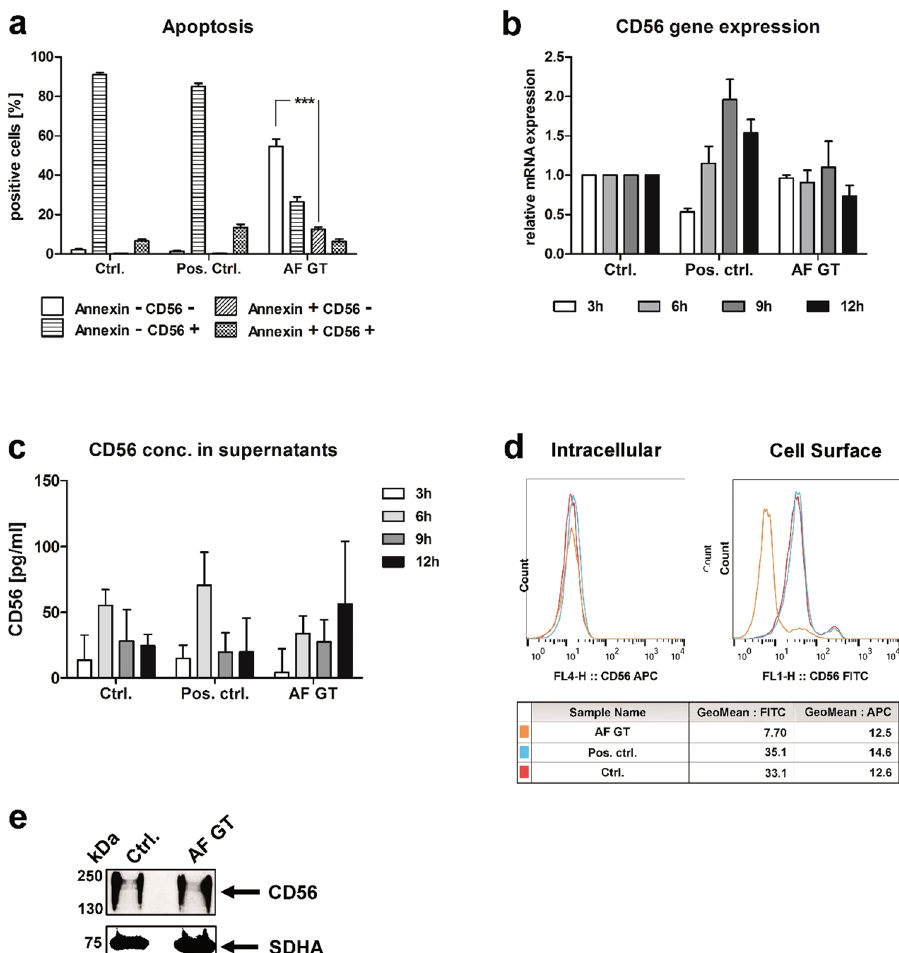
Figure 2. CD56 reduction is not induced by apoptosis, deregulation of protein and gene expression. NK cells were either treated with 500 U/ml IL-15 and IL-2 (Pos. ctrl.), with A . fumigatus germ tubes (AF GT, MOI 0.5) or left untreated (Ctrl.). ( a ) Induction of apoptosis was determined 9 h after co-cultivation and ( b ) mRNA/transcript expression after different incubation times was quantified by real-time RT-qPCR. ( c ) CD56 withdrawal was analysed by ELISA. ( d ) Intracellular and membranous CD56 expression was analysed by flow cytometry 6 h after co-cultivation, representative data of three independent experiments. Red line: NK cells (Ctrl.); blue line: NK cells treated with IL-15 and Proleukine (Pos. ctrl.); orange line: NK cells treated with A . fumigatus (AF GT). ( e ) Protein concentrations were visualized by western blot analyses 4 h after co-cultivation. Blots were cropped and image processing was performed by Adobe Photoshop software. Representative data of five independent experiments. Data of ( a – c ) are represented as mean + SEM for ( a ) n = , ( b ) n = and ( c ) n = 3). Significant differences are marked with an asterisk ( *** p <